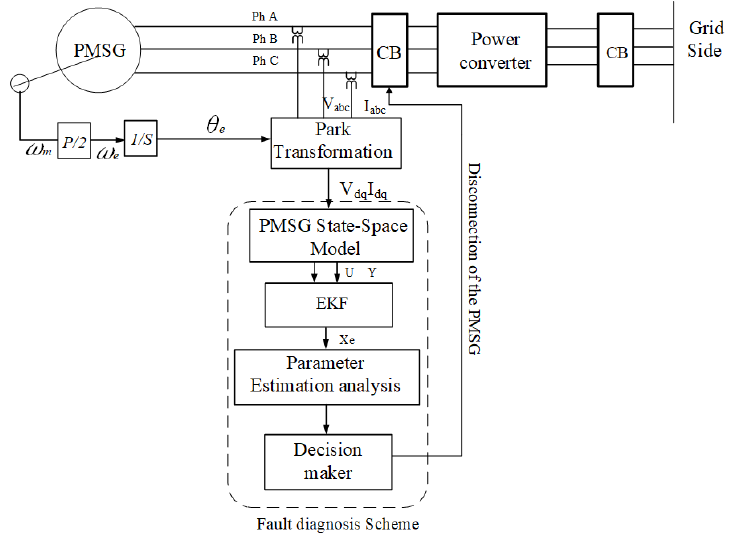
Figure 7. PMSG fault diagnosis on-line monitoring block diagram.